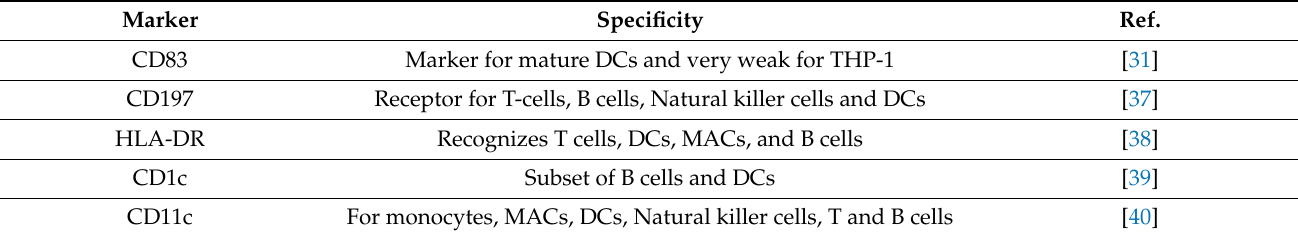
Table 1. Markers used for immune cells and their specifications.